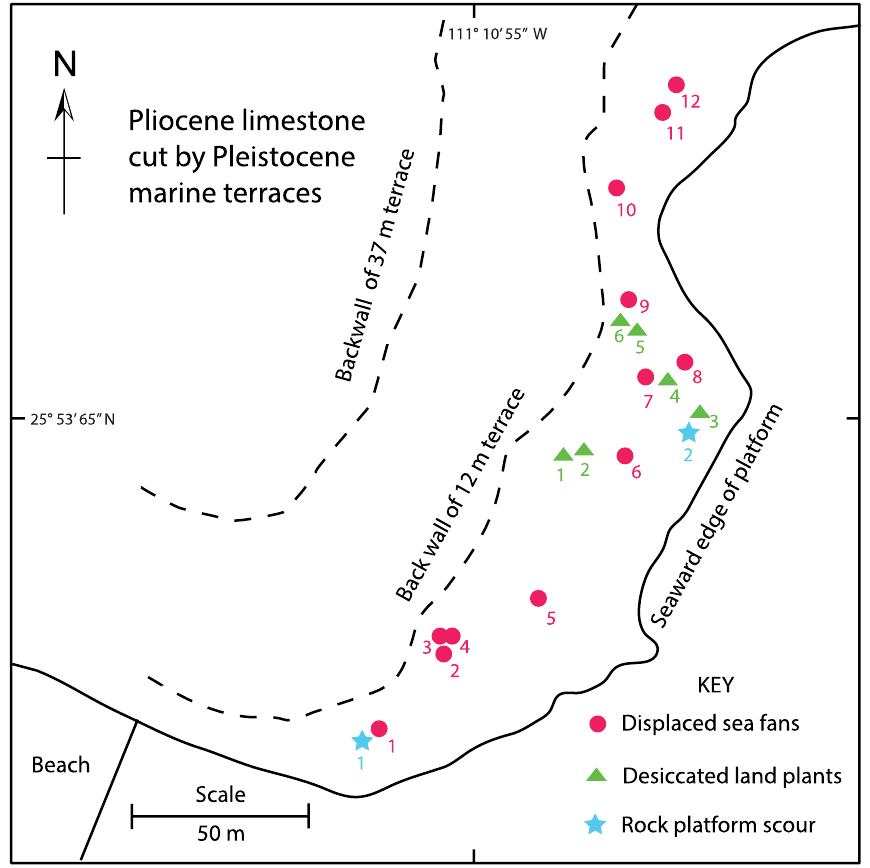
Figure 2. Map covering approximately 6000 m 2 on the 12 m limestone terrace adjacent to the access beach at Arroyo Blanco on the east coast of Isla del Carmen. The marked locations for displaced sea fans and desiccated land plants are numbered for reference to data supplied in Tables 1 and 2. Key features showing the effect of wave scour on the platform also are marked.